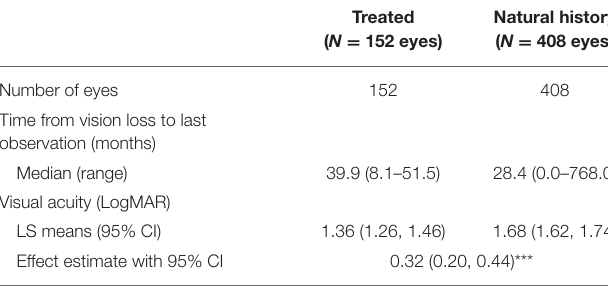
TABLE 4 | Visual acuity in treated eyes vs. natural history eyes at last observation—multivariate analysis with age and duration of follow-up as